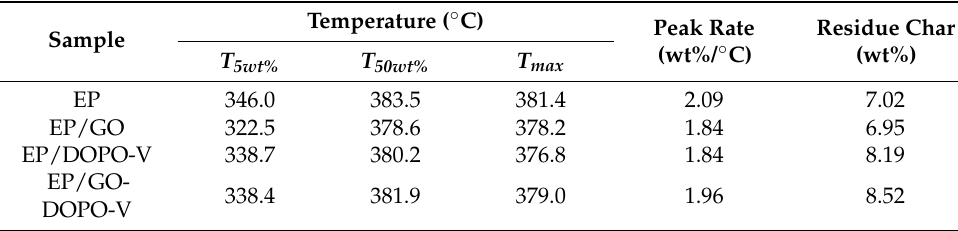
Table 1. TGA data of EP, EP/GO, EP/DOPO-V and